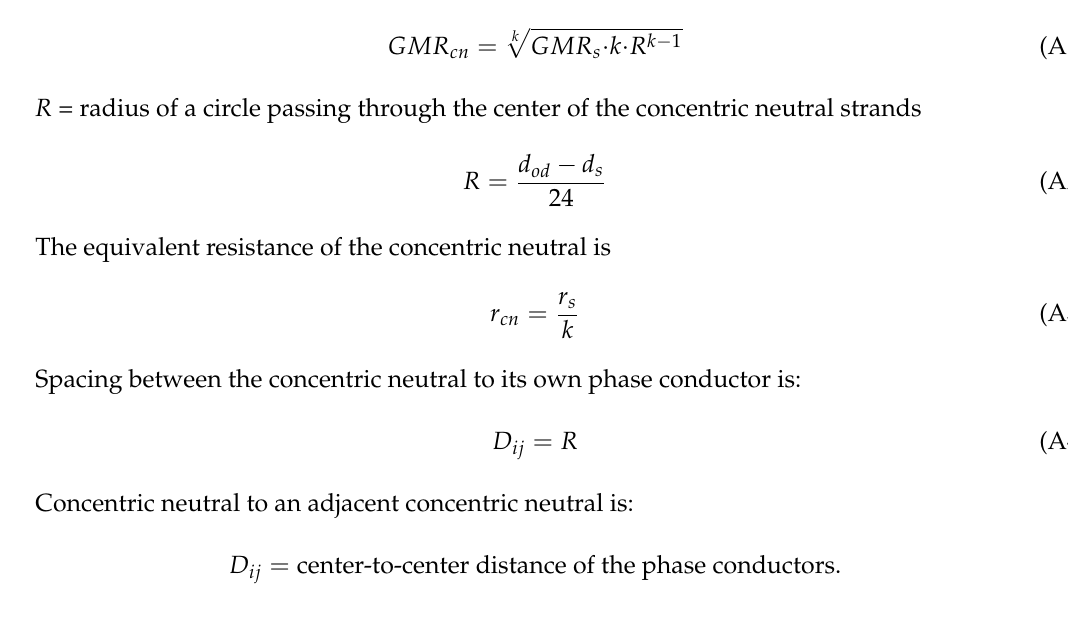
Figure A2. Distance between concentric neutral cables. The simplified Carson’s equations used to obtain the primitive matrix of impedance are: (cid:1878) (cid:3036)(cid:3036) = (cid:1870) (cid:3036) + 0.09530 + (cid:1862)0.12134(ln (cid:3436) 1 (cid:1833)(cid:1839)(cid:1844) (cid:3036) (cid:3440) + 7.93402)